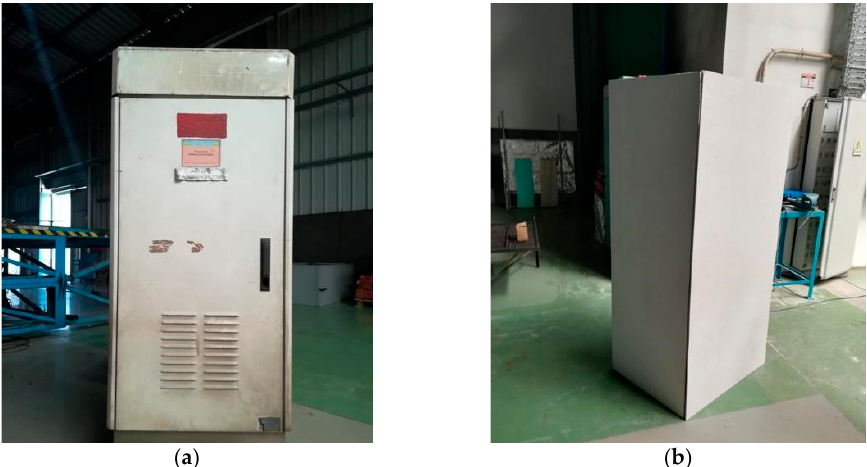
Figure 1. ( a ) Telecommunication cabinet and the ( b ) protected telecommunication cabinet.